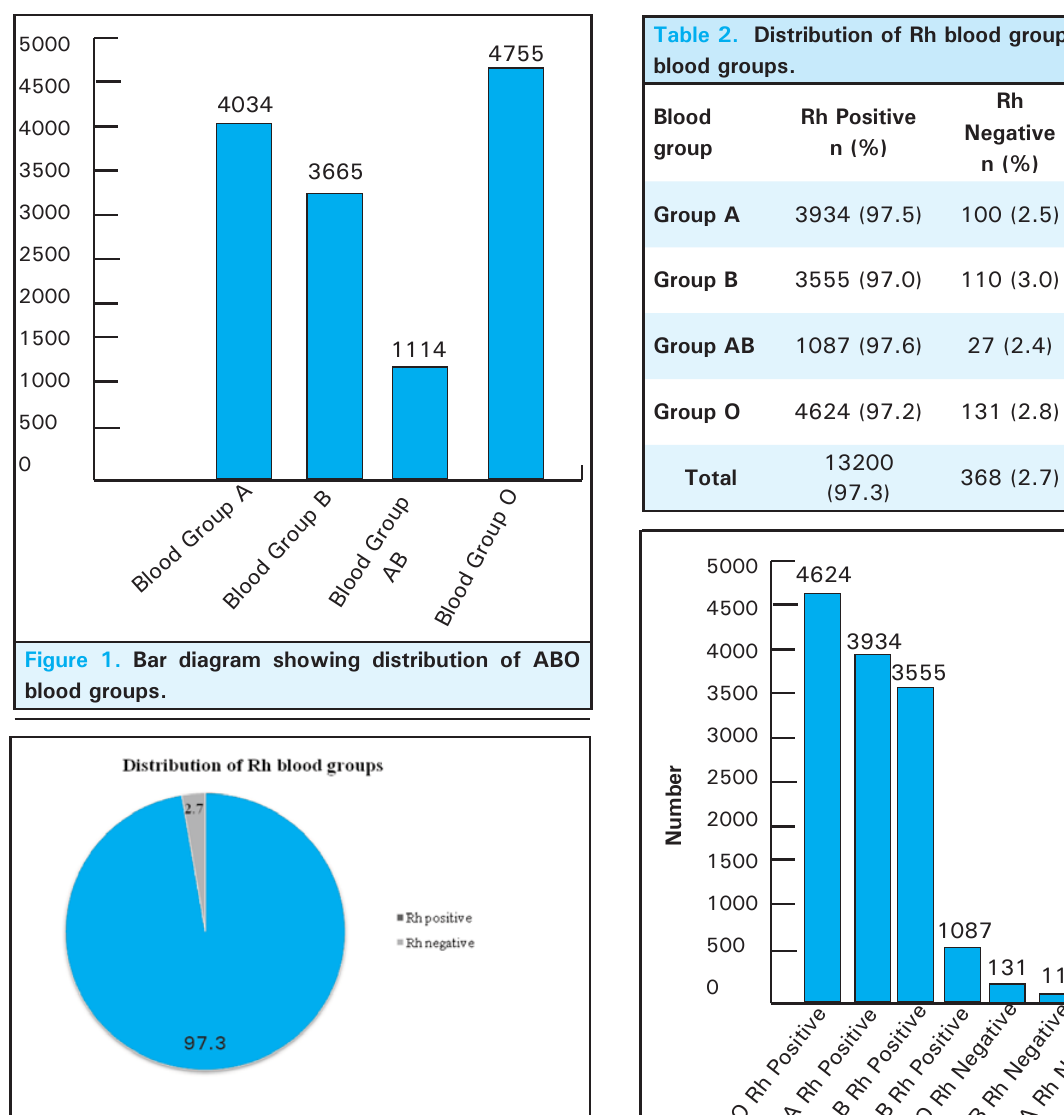
Figure 2. Pie chart showing distribution of Rh blood groups. The frequencies of blood groups A, B, AB and O are found to be 4034 (29.7%), 3665 (27.0%), 1114 (8.2%) and 4755 (35.1%) respectively (Figure 1). The frequencies of Rh positive and Rh negative blood groups are found to be 13200 (97.3%) and 368 (2.7%) respectively (Figure